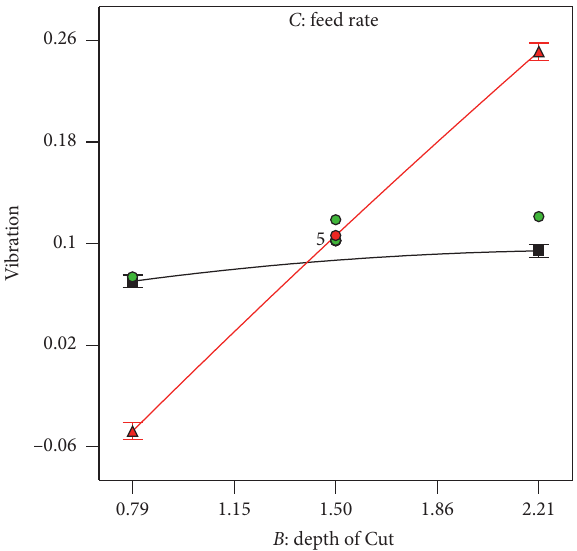
Figure 9: Interaction plot for the depth of cut vs. feed rate.